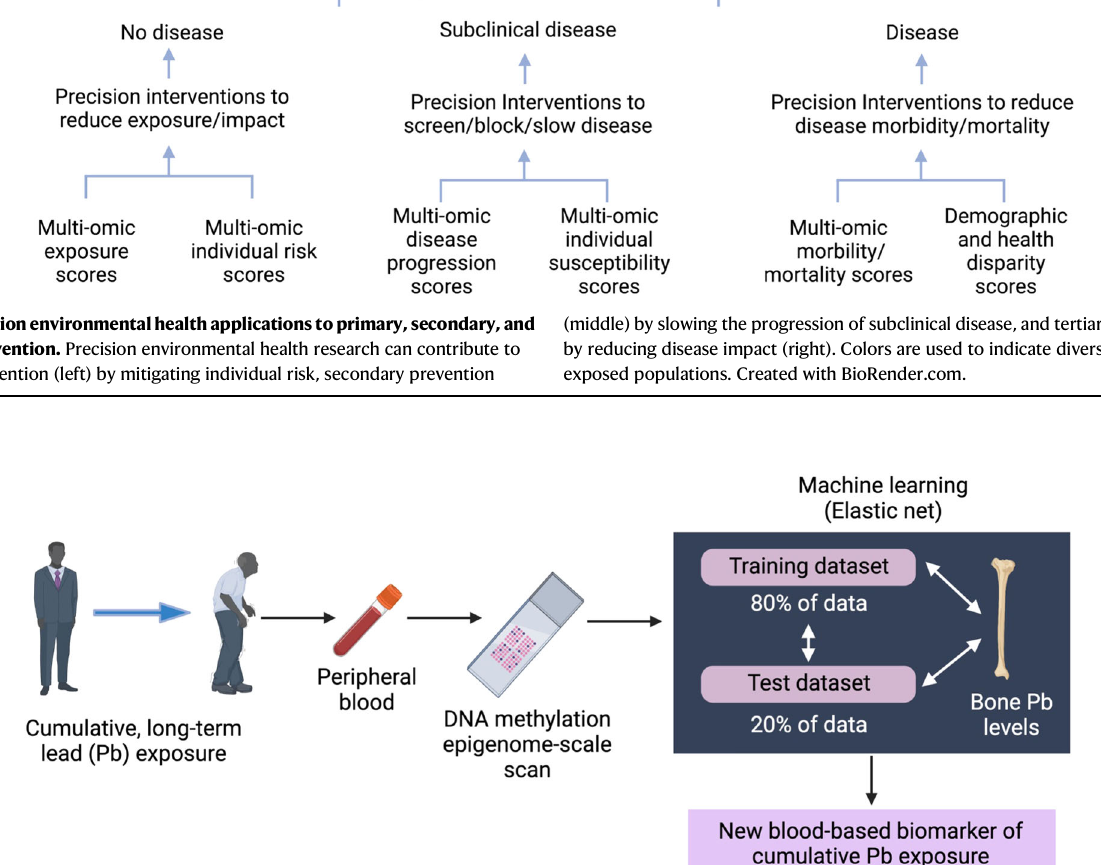
exposure and were available in the study. This type of epigenetic biomarker holds greatpromisetocaptureandaccuratelyassesslong-term,cumulativeexposuresto environmental and lifestyle factors. Created with BioRender.com.